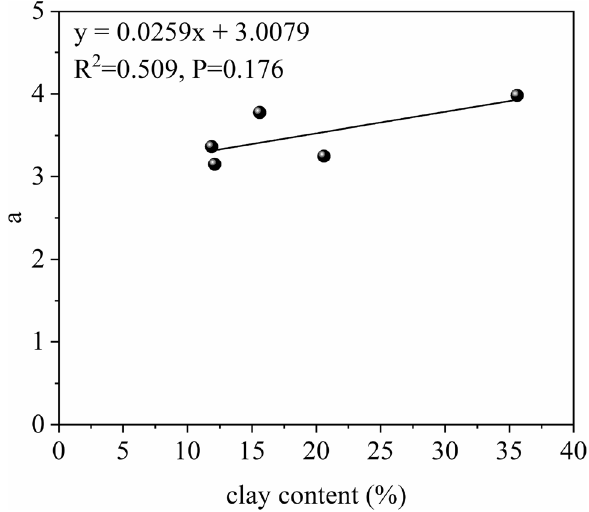
Fig. 8 Relationship between clay content and coefficient of regres- sion